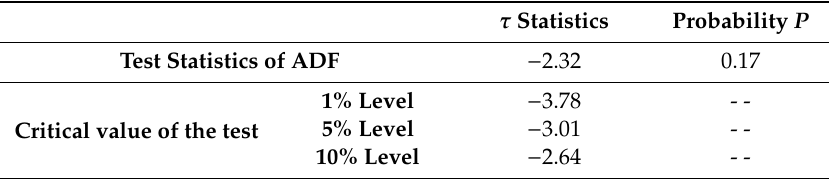
Figure 4. Autocorrelation coefficient and partial autocorrelation coefficient of pit gain time series after the first-order difference. Table 2. Unit root test results of the pit gain time series after the first-order difference.